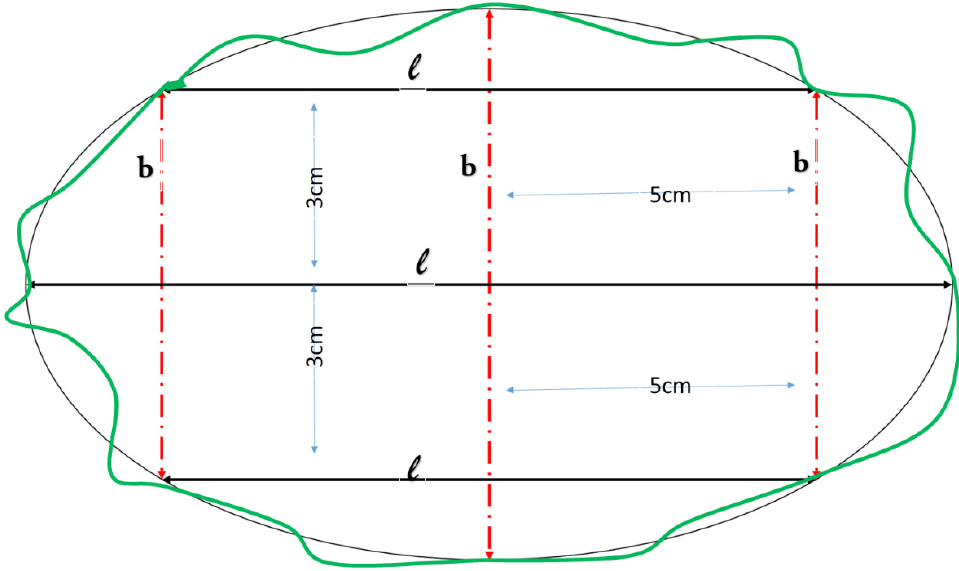
Fig 2 . Diagrammatic representation of a nest and the location of the measurement taken for nest area.